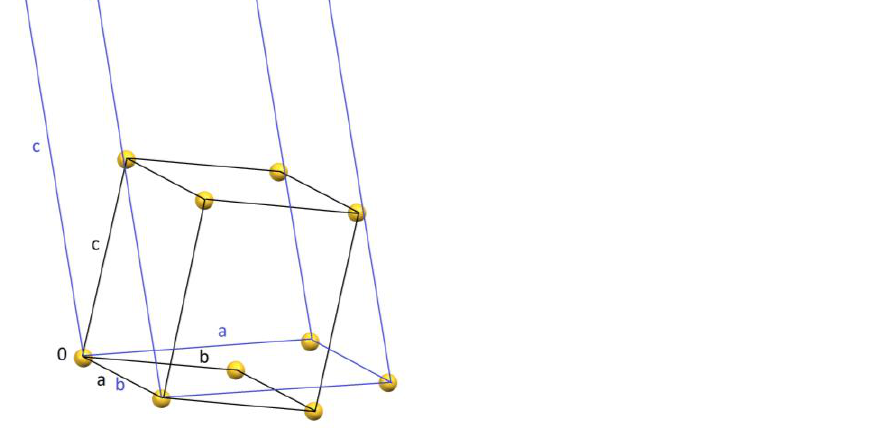
Figure 2. The relation between triclinic (black lines and letters) and monoclinic (blue lines and let- ters) unit cells. Origin is the same, small yellow spheres are the lattice points.